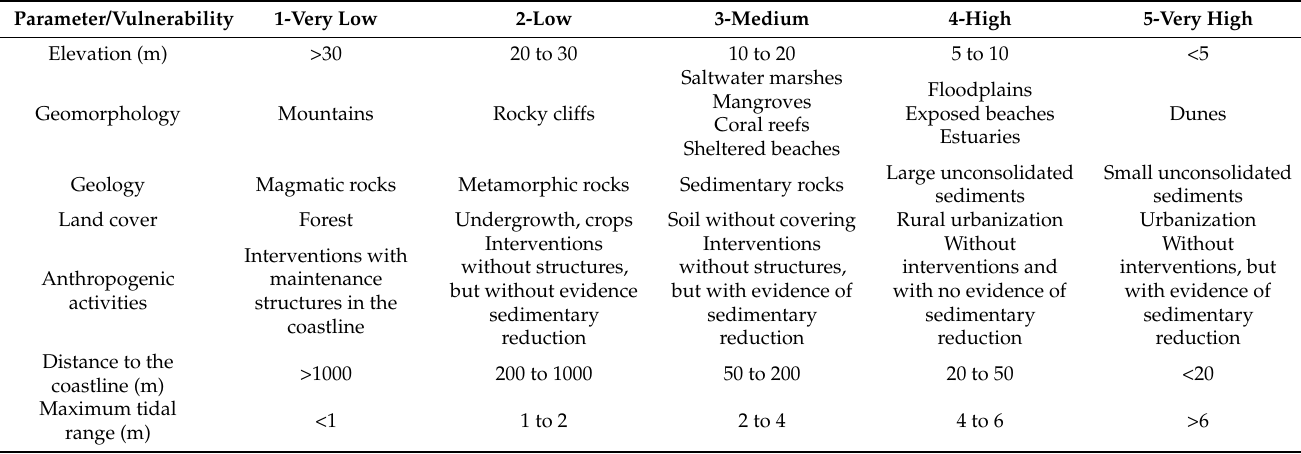
Table 1. Defined parameters for the study area, being each attribute of each parameter associated with a vulnerability category